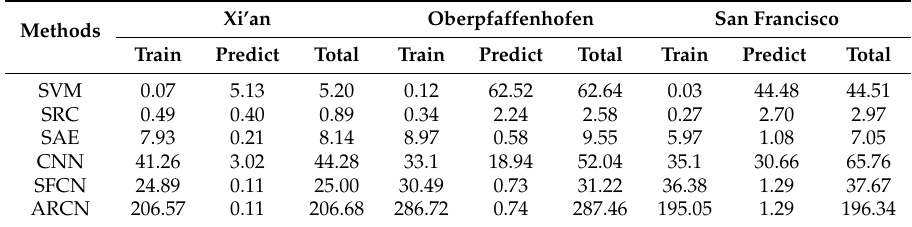
Table 4. Execution time of the three PolSAR Images with different methods